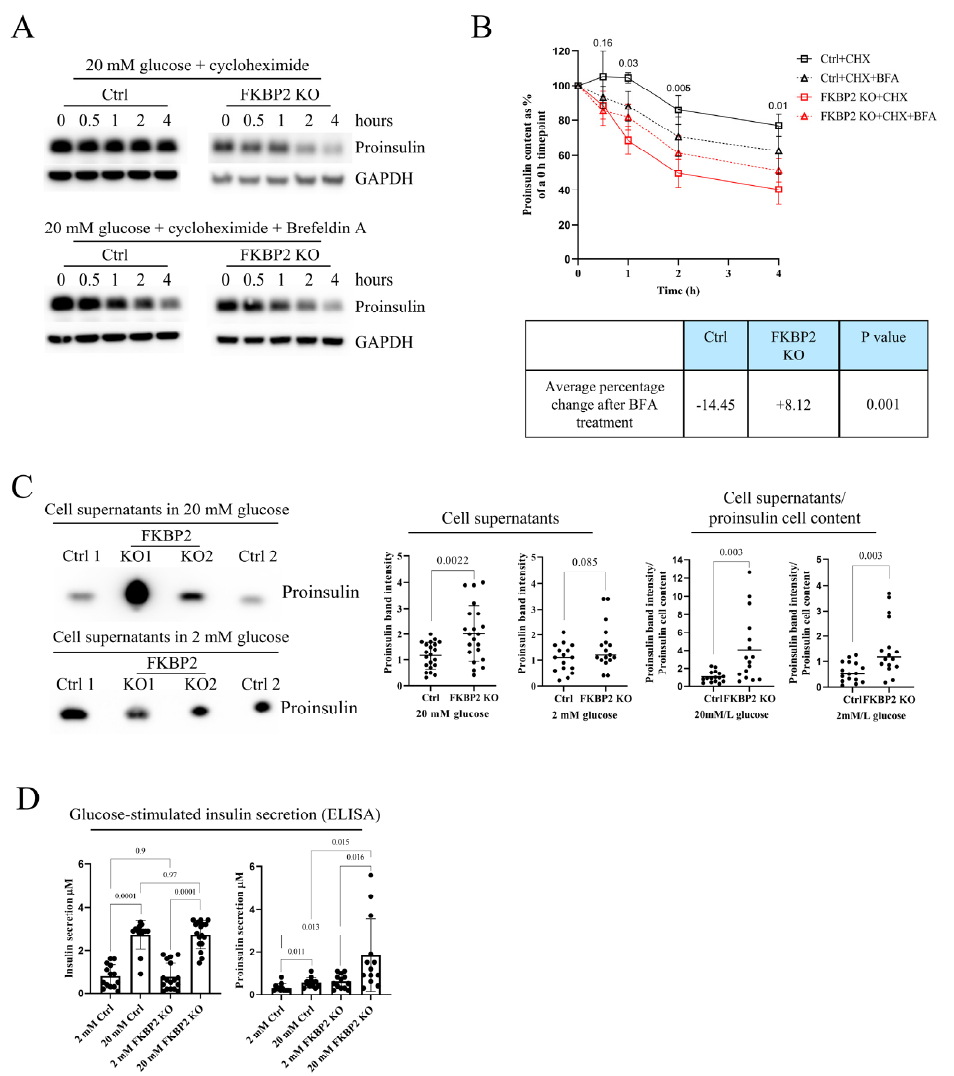
Figure 5. FKBP2 KO shortens proinsulin intracellular half-life and increases its secretion. ( A , B ). INS − 1E control (Ctrl) and FKBP2 KO cells were cultured for 3 h in 2 mM glucose-containing media. subsequently, 100 µ M of the protein synthesis inhibitor cycloheximide (CHX, upper panels) and 200 nM of the inhibitor of exocytosis Brefeldin A (BFA, bottom panels) were added to the culture media from the start of the experiment. Cells were lysed at indicated time points, analyzed via reducing SDS-PAGE, and proinsulin and insulin were visualized through Western blotting (WB) with an anti-proinsulin antibody, n = 5. B. WB data quantification. Top: graph p values were calculated by unpaired t-test of Ctrl + CHX vs. FKBP2 KO + CHX for each time point. Bottom: Table with averages of changes of Ctrl and FKBP2 KO cells over the course of experiment in proinsulin content (band intensity) in response to BFA treatment. ( C ). Accumulated secretion of proinsulin over the period of 4 h in 2 or 20 mM glucose by failed FKBP2 KO (Ctrl 1 and 2) and FKBP2 KO cells, analyzed by SDS-PAGE and WB ( n = 10). In total, 500 µ L of cell supernatants (adjusted to cell number) was concentrated using 10 kDa MWCO filters to remove salts and reduce the volume to 15 µ L. Quantification of proinsulin bands was carried out with ImageJ ( A , B ) and normalized to GADPH ( A ) bands. Data are presented as means ± SD analyzed by unpaired t-test of treatments versus control. ( D ). The same cell types were tested for their ability to secrete insulin in response to the given glucose concentrations in KRBH buffer for a period of 30 min. Supernatants were analyzed by ELISAs specifically detecting mature insulin (left graph) or proinsulin (right graph) only. The bars represent the means ±